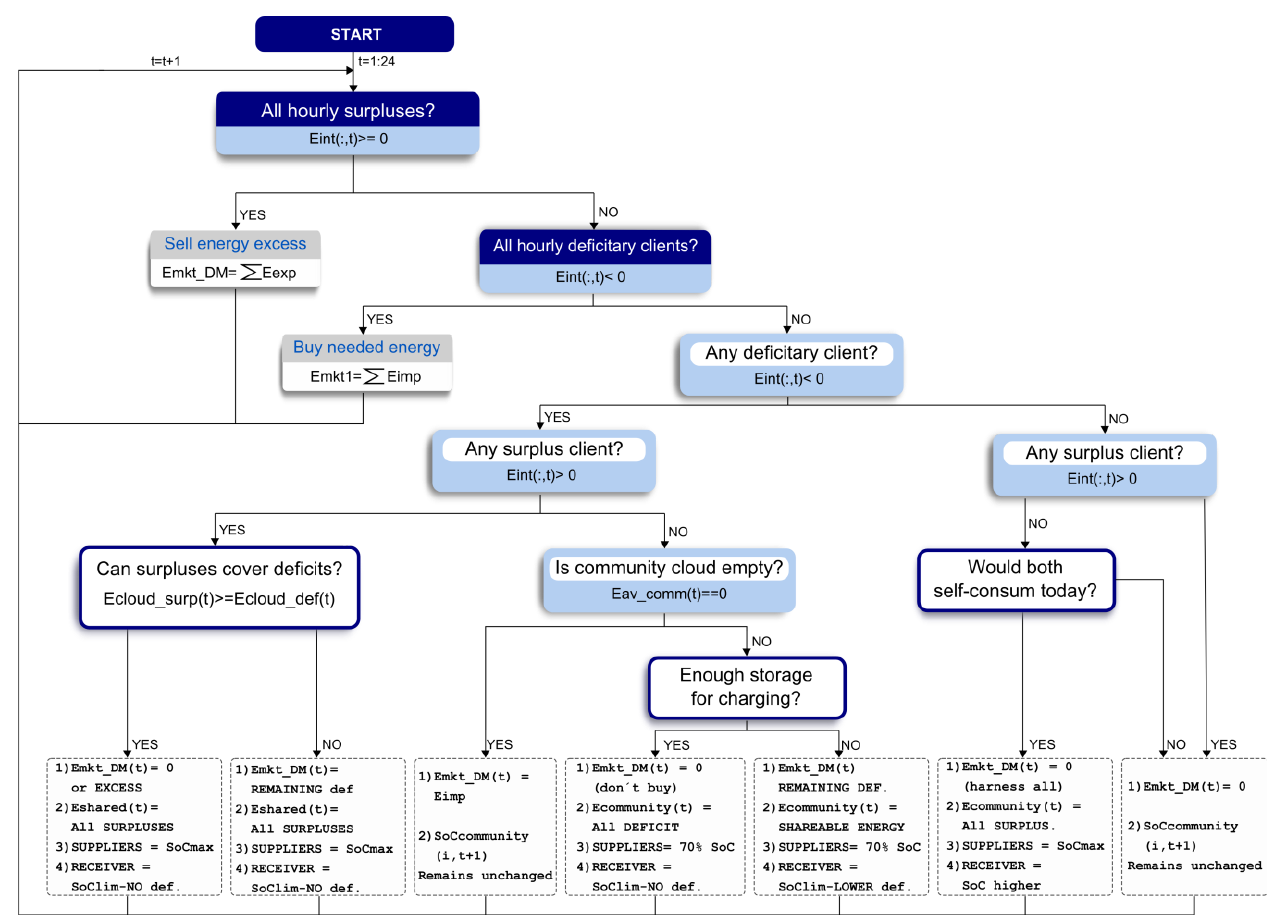
Figure 3. Simplified community- level algorithm’s diagram flux.